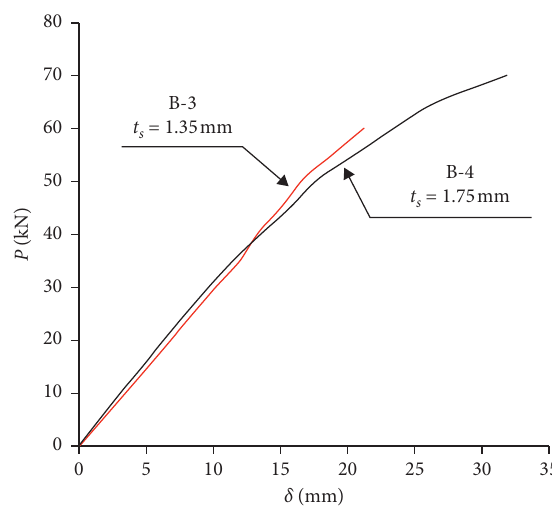
Figure 9: Effect of steel channel thickness on load-deflection curve.